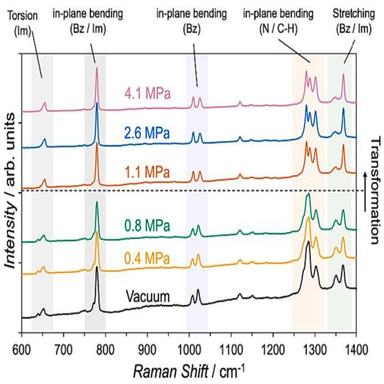
Raman spectra of ZIF-7 at varying pressures of methane, indicating a structural transition occurred between (0.8 and 1.1) MPa. Each shaded band is assigned to a vibrational mode of a molecular bond; peak assignment in supporting information of ref. Each spectrum is offset vertically for clarity.